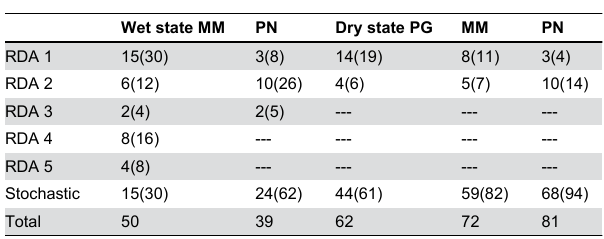
Table 2. Number of species correlating with significant canonical (RDA) axes revealed by Spearman rank correlation analyses, and the number of species that were not significantly correlated with any RDA axis